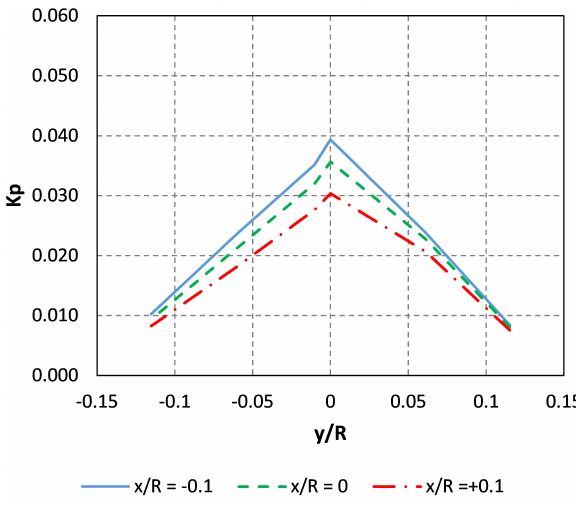
Figure 15: First harmonic values in correspondence to different points on the hull stern. Influence of the longitudinal position with the full-scale Nominal inflow wake.